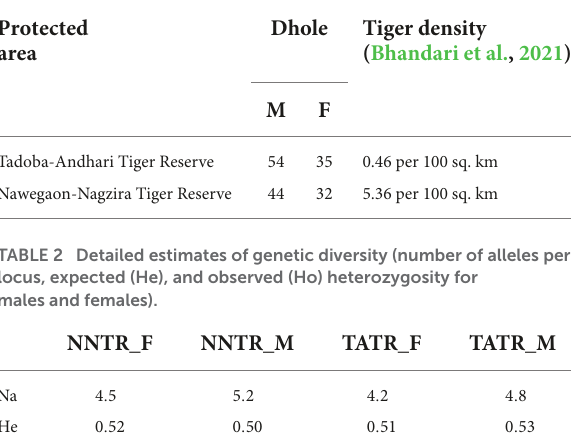
TABLE 1 Detailed description of dhole individuals and tiger density in the study area. Protected area